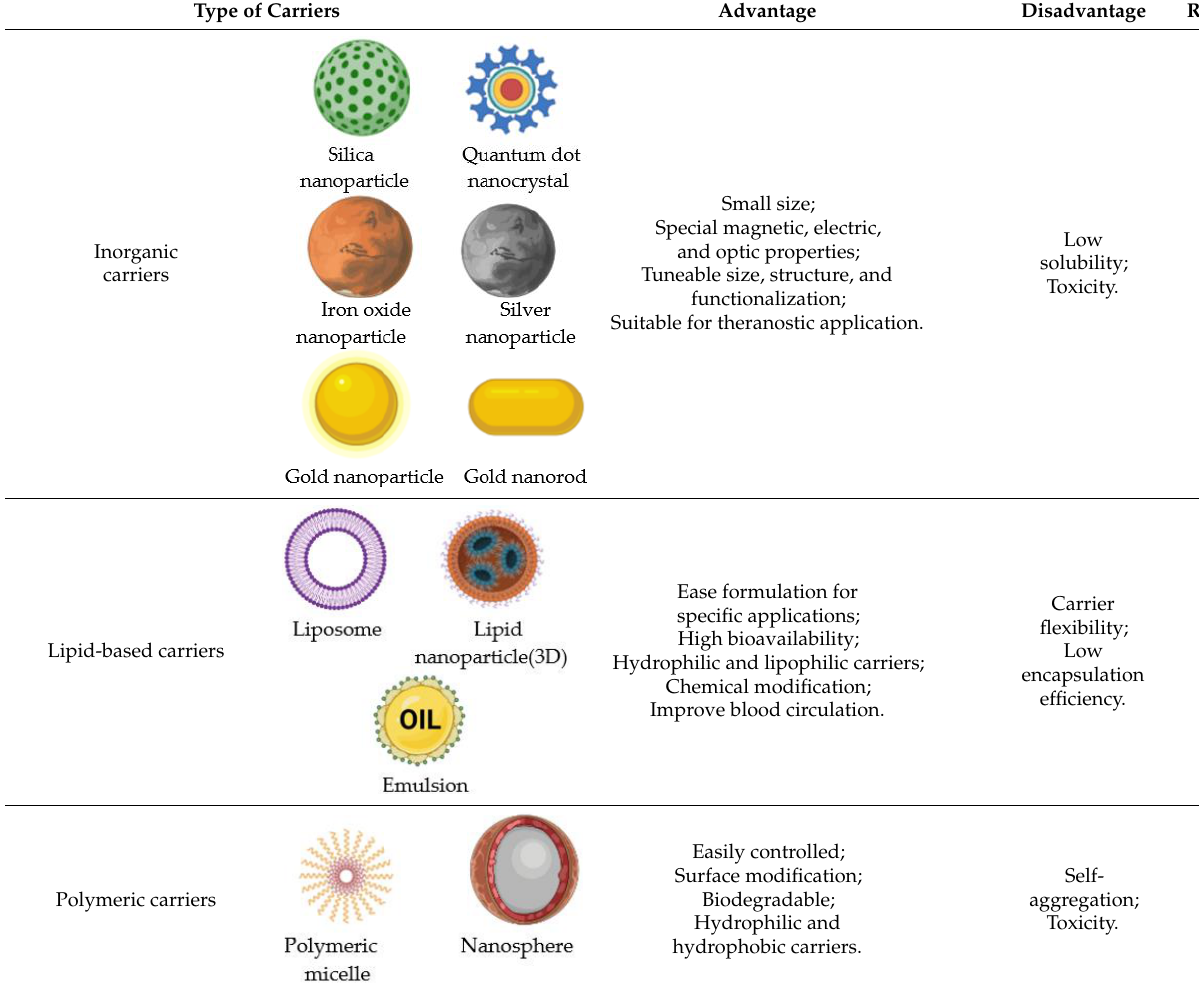
Table 1. Type of nanoparticles used as carriers.